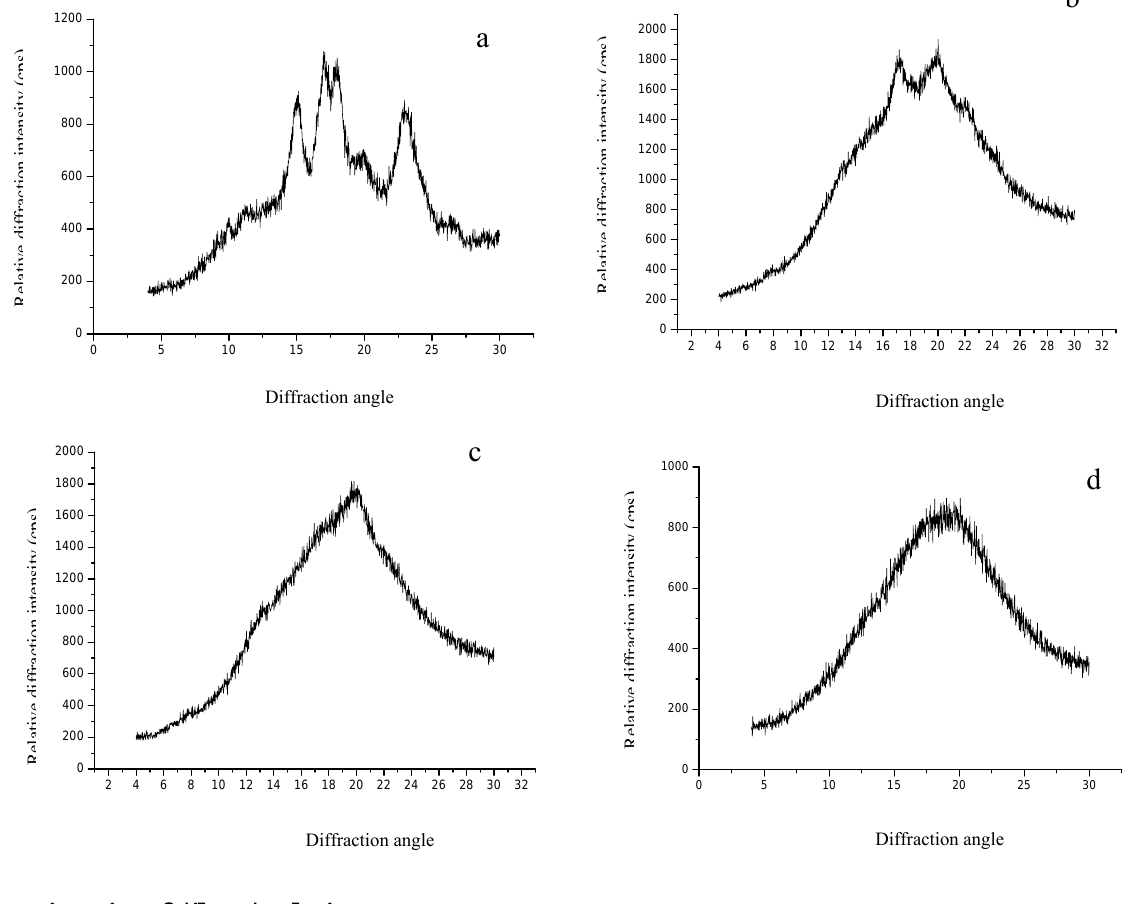
Figure 2. X-ray diffraction spectra of the starch and the dextrins: (a) native starch; (b) dextrin (DE 9); (c) dextrin (DE 15); (d) dextrin (DE